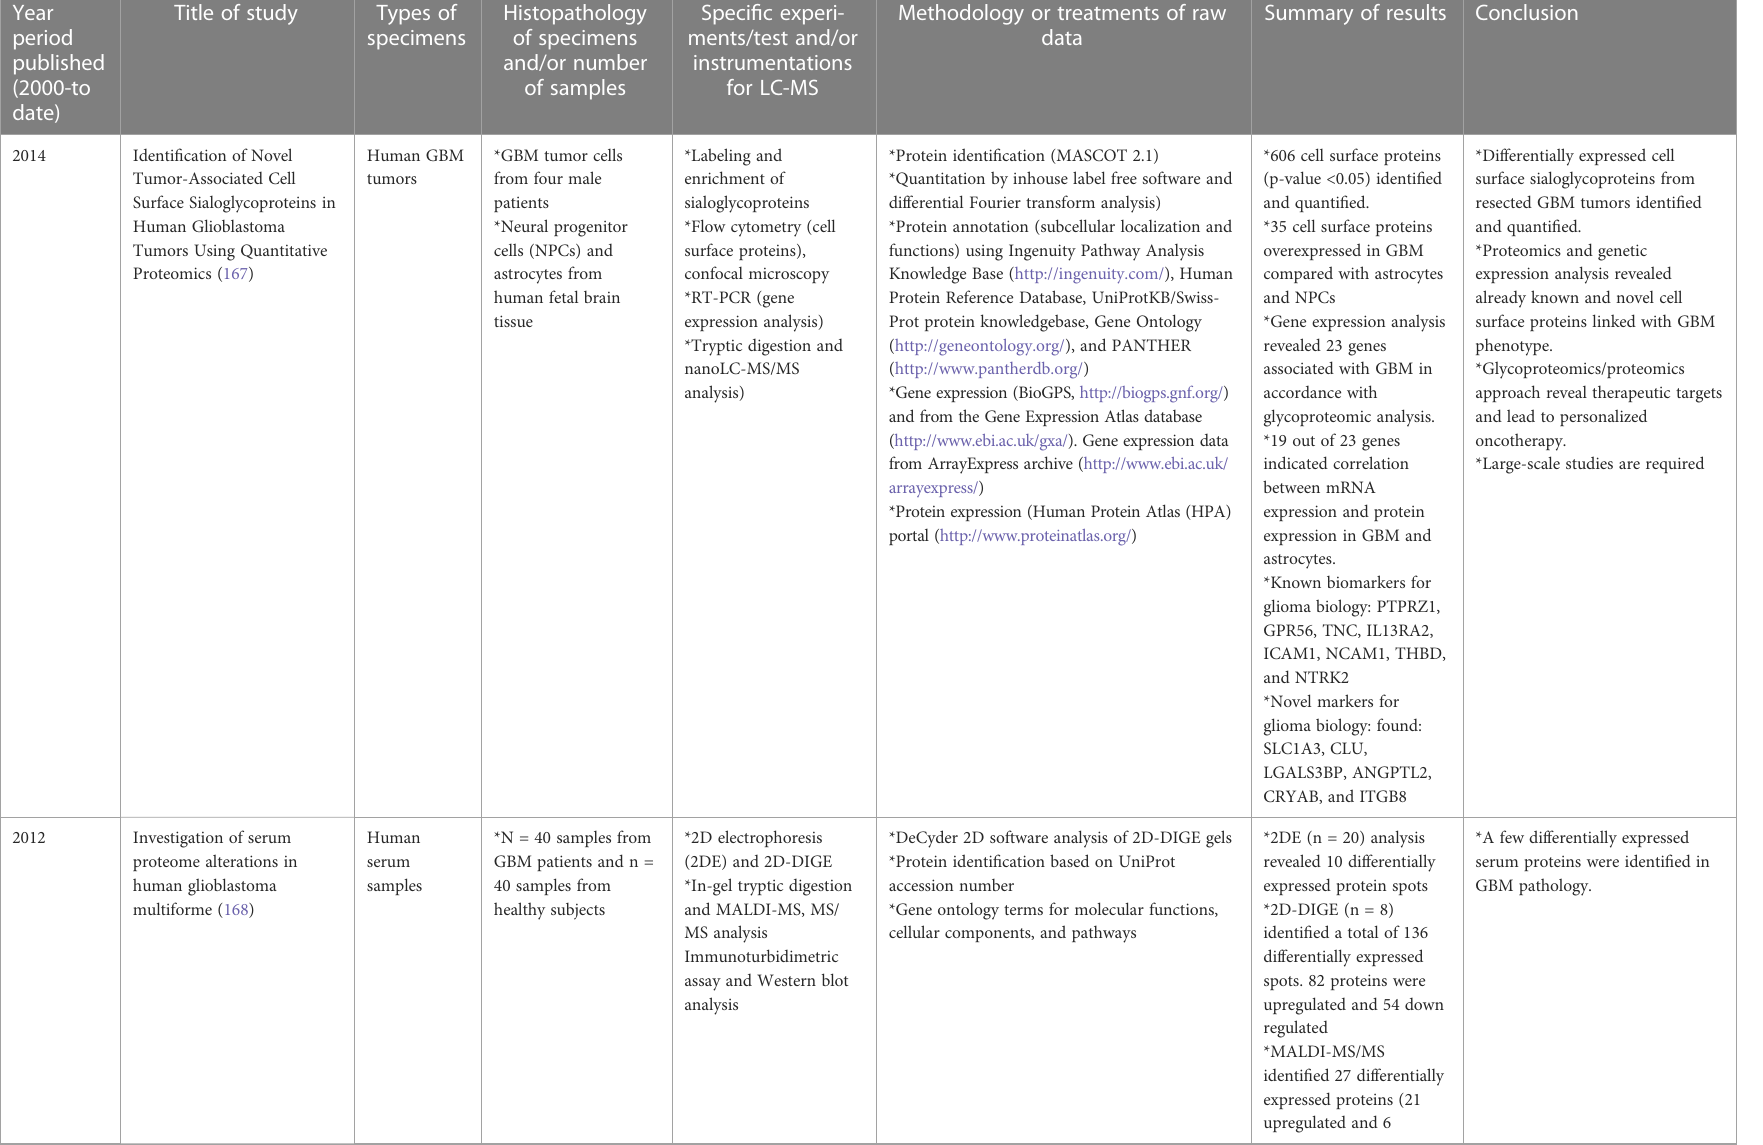
TABLE 1 Selective list of proteomics studies conducted (from year 2000 to date) on human GBM specimens to understand pathophysiology and cellular biology.